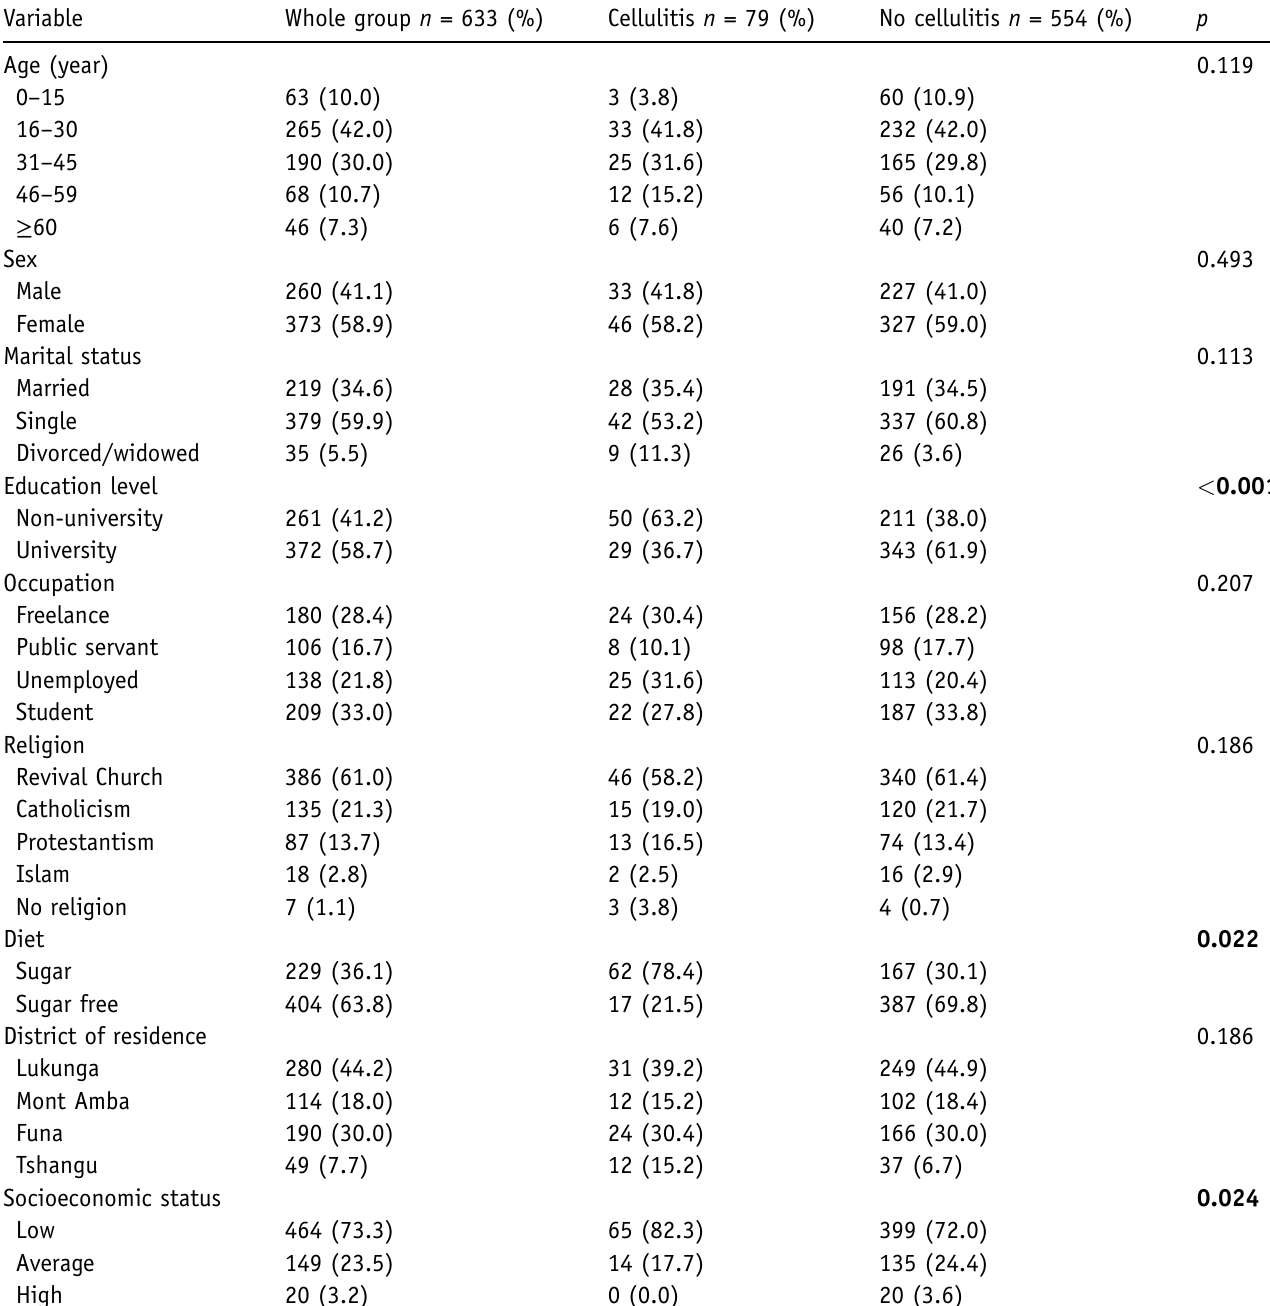
Table 1. Sociodemographic characteristics of the population with dental cellulitis versus control